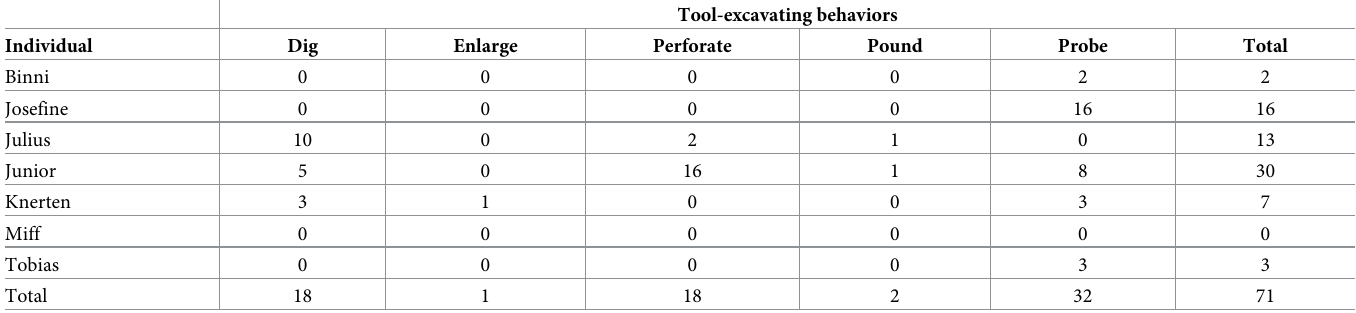
Table 1. Number of events of each excavating behavior performed by each individual during the Loose Soil Condition of Experiment 1. In two events the individual could not be identified.